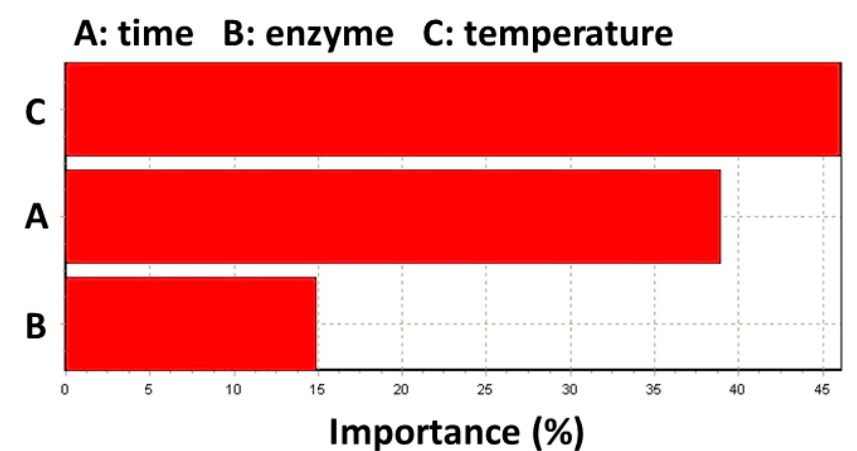
Figure 4. Importance of experimental variables on lipase-catalyzed synthesis of 2-ethylhexyl ferulate.